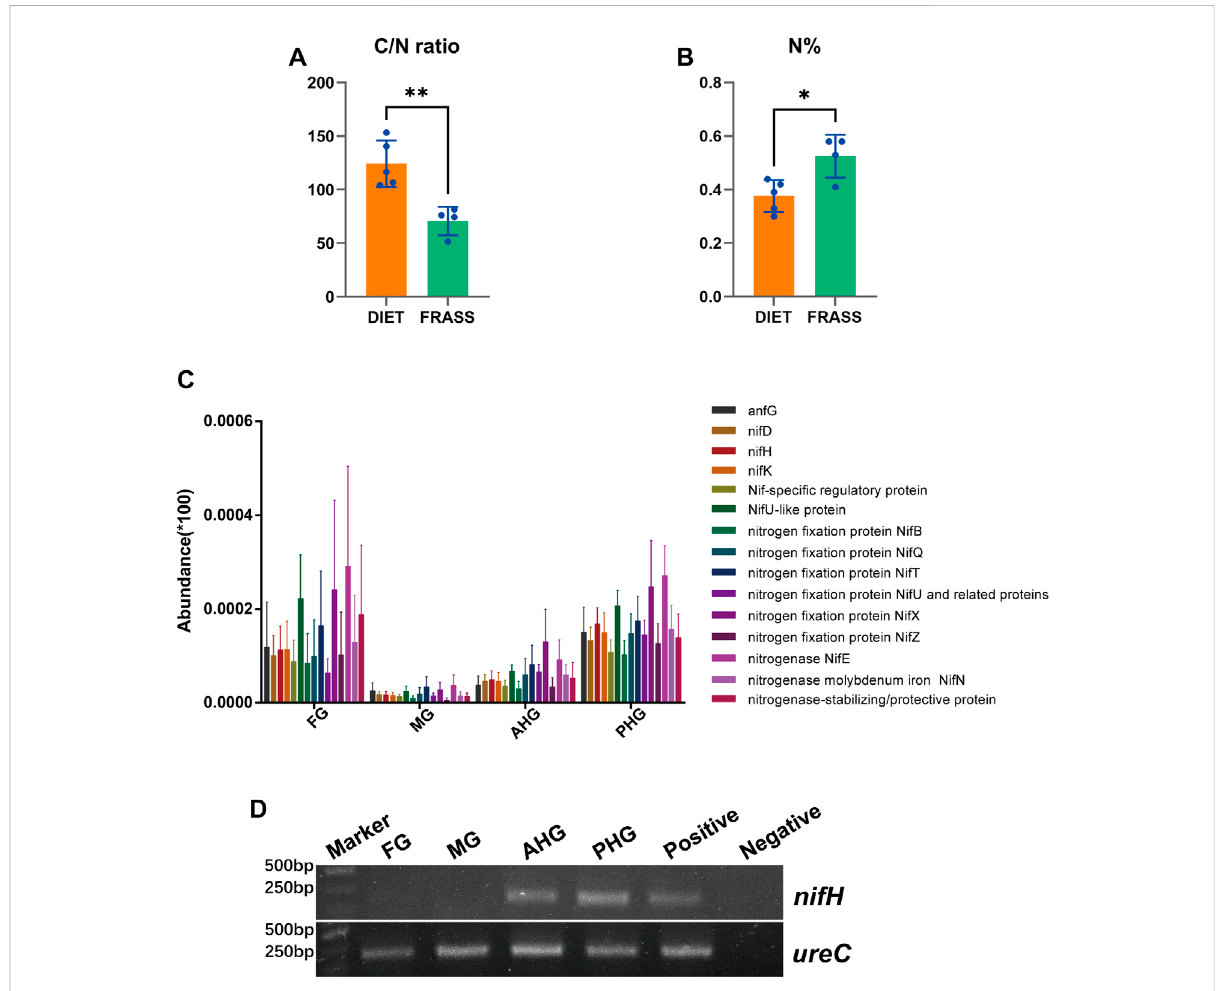
FIGURE 5 Comparative analysis of nitrogen fi xation-related genes and their expression in four gut segments of A. swainsoni larvae. (A,B) Comparison of carbon/nitrogen(C/N)ratio (A) andnitrogenconcentrations (B) inwoodandguttissueof A.swainsoni larvae. (C) Genescodingforenzymesinvolved innitrogen fi xationweredetectedthroughthefourgutregionsoffour A.swainsoni larvae,withhigherabundancelevelsdetectedatFGandPHG. (D) RT-PCR of key nitrogen fi xing gene nifH. UreC gene expression was also detected. The * indicates p ≤ .05, and the ** indicates .001 < p ≤